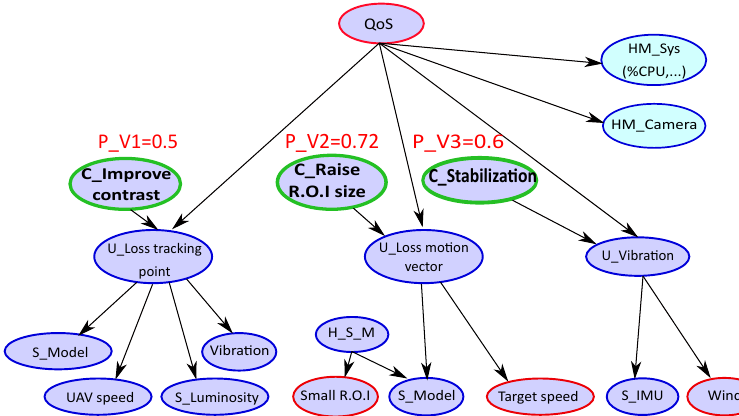
Figure 20. BN for tracking application with mitigation